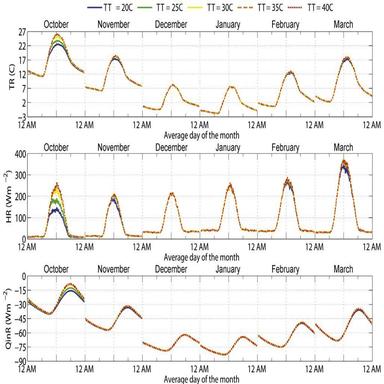
Roof external surface temperature (TR), outward sensible heat flux (HR) and inward heat flux (QinR) monthly-averaged diurnal cycles of the autumn and winter months, for the five considered transition temperatures, i.e. 20, 25, 30, 35 and 40 °C.